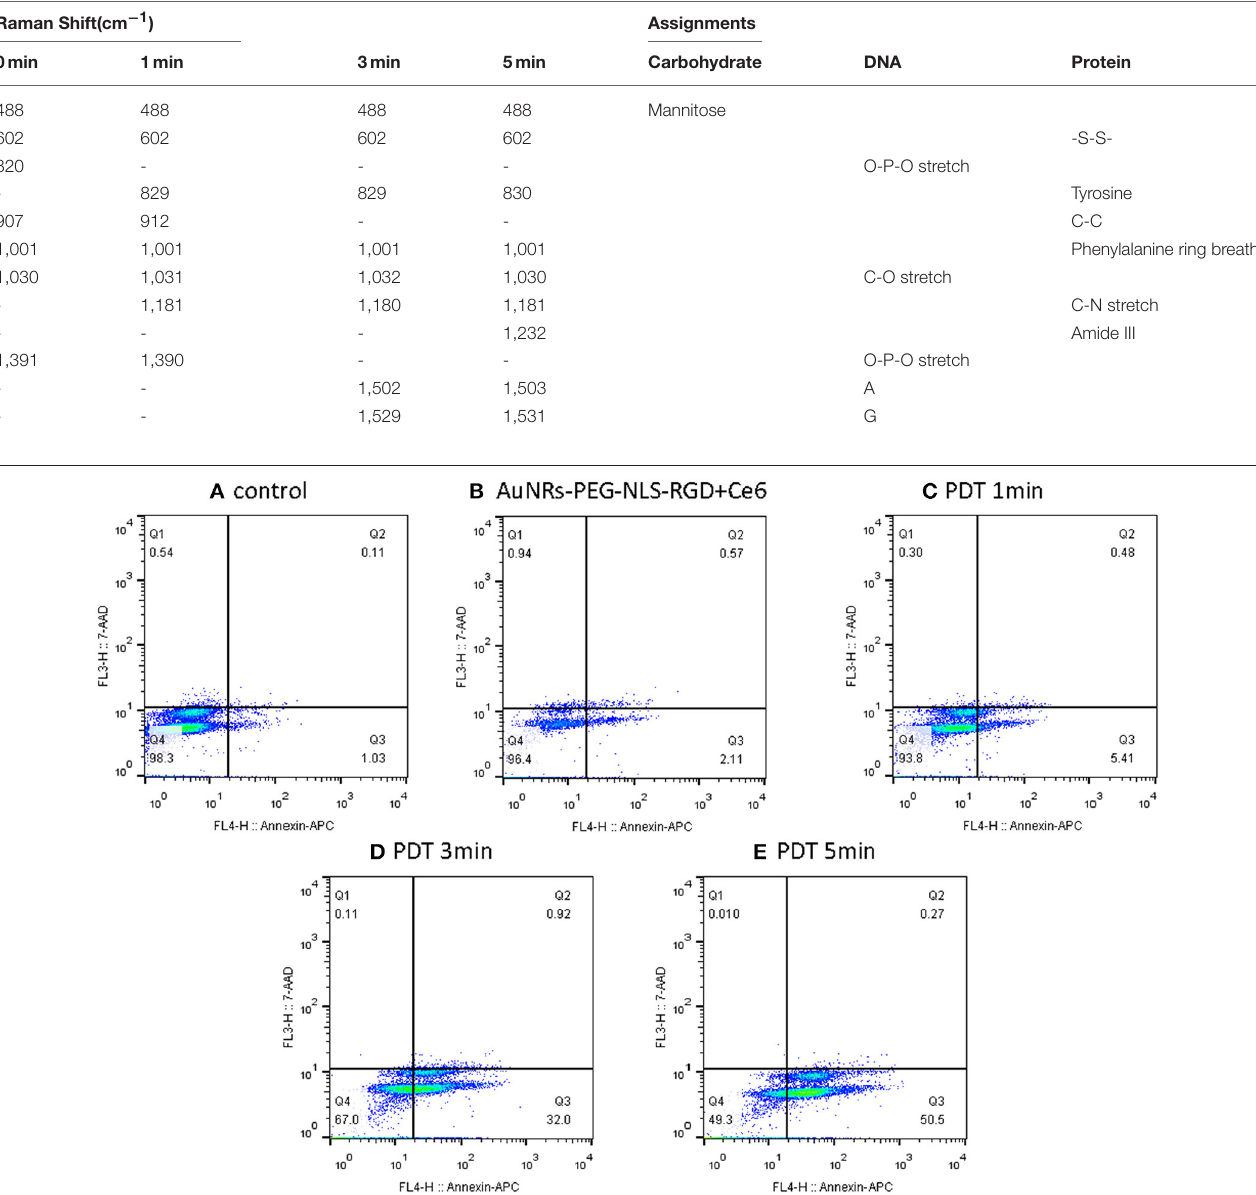
TABLE 1 | The band assignment of the SERS spectra of the main components in B16 cell nucleus. Raman Shift(cm − 1 )